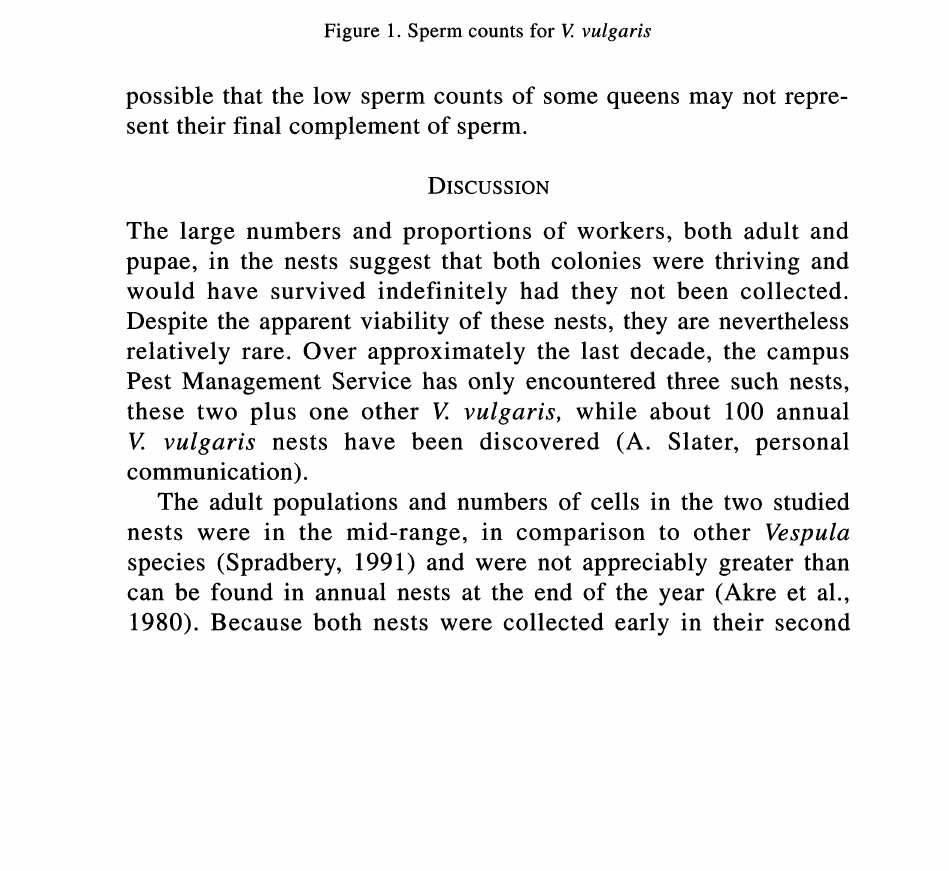
Figure 1. Sperm counts for V.